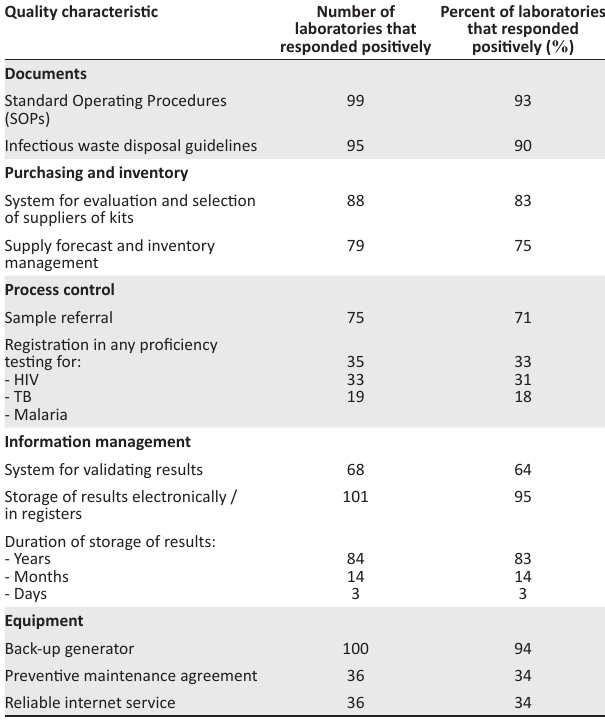
TABLE 1: Survey results of the 106 surveyed